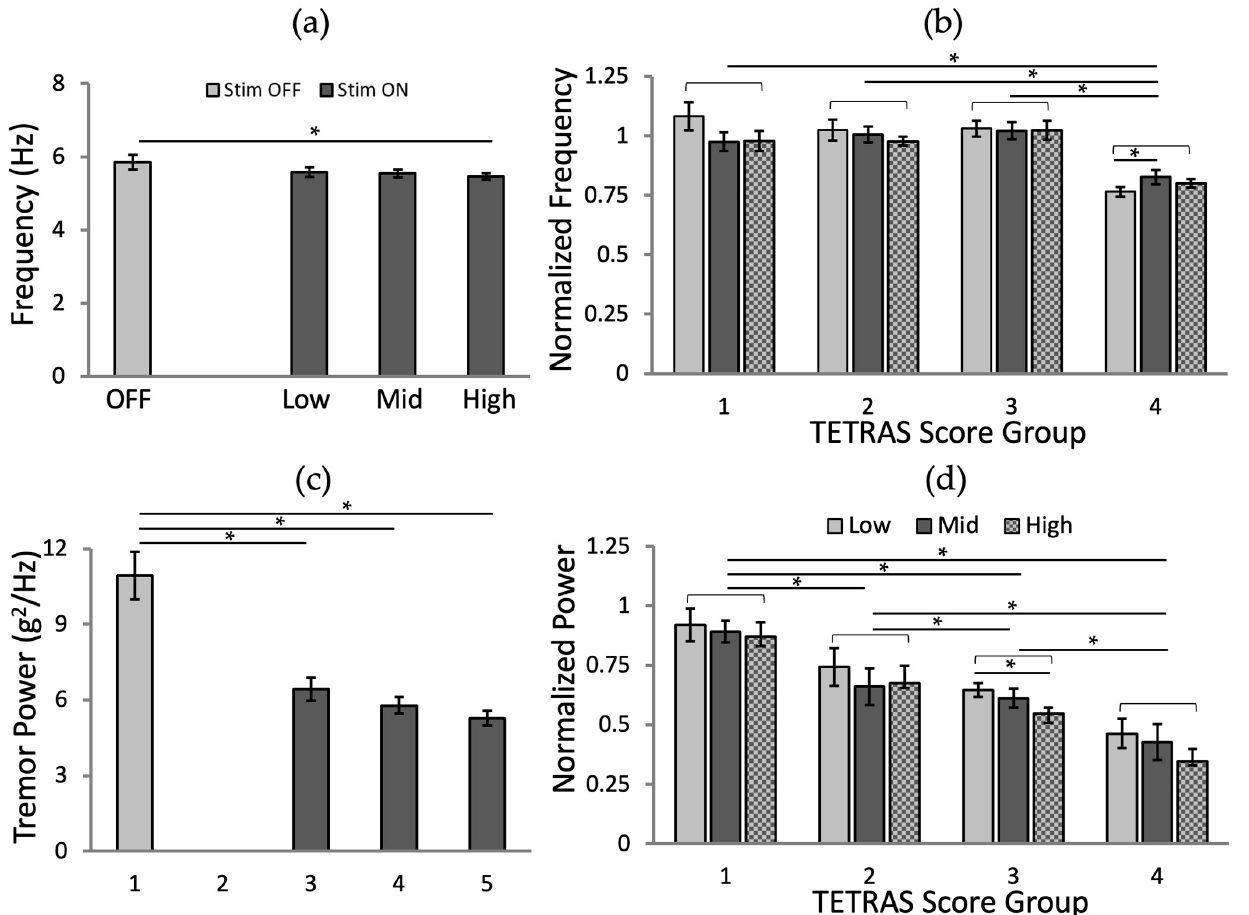
Figure 7. The effects of the stimulation amplitudes (low, mid, and high) by tremor metrics: ( a ) Tremor frequency and ( c ) power. The normalized tremor metrics for the different amplitudes by the TETRAS Score groups: ( b ) Tremor frequency and ( d ) power. The error bars represent the standard errors. *: p < 0.05.